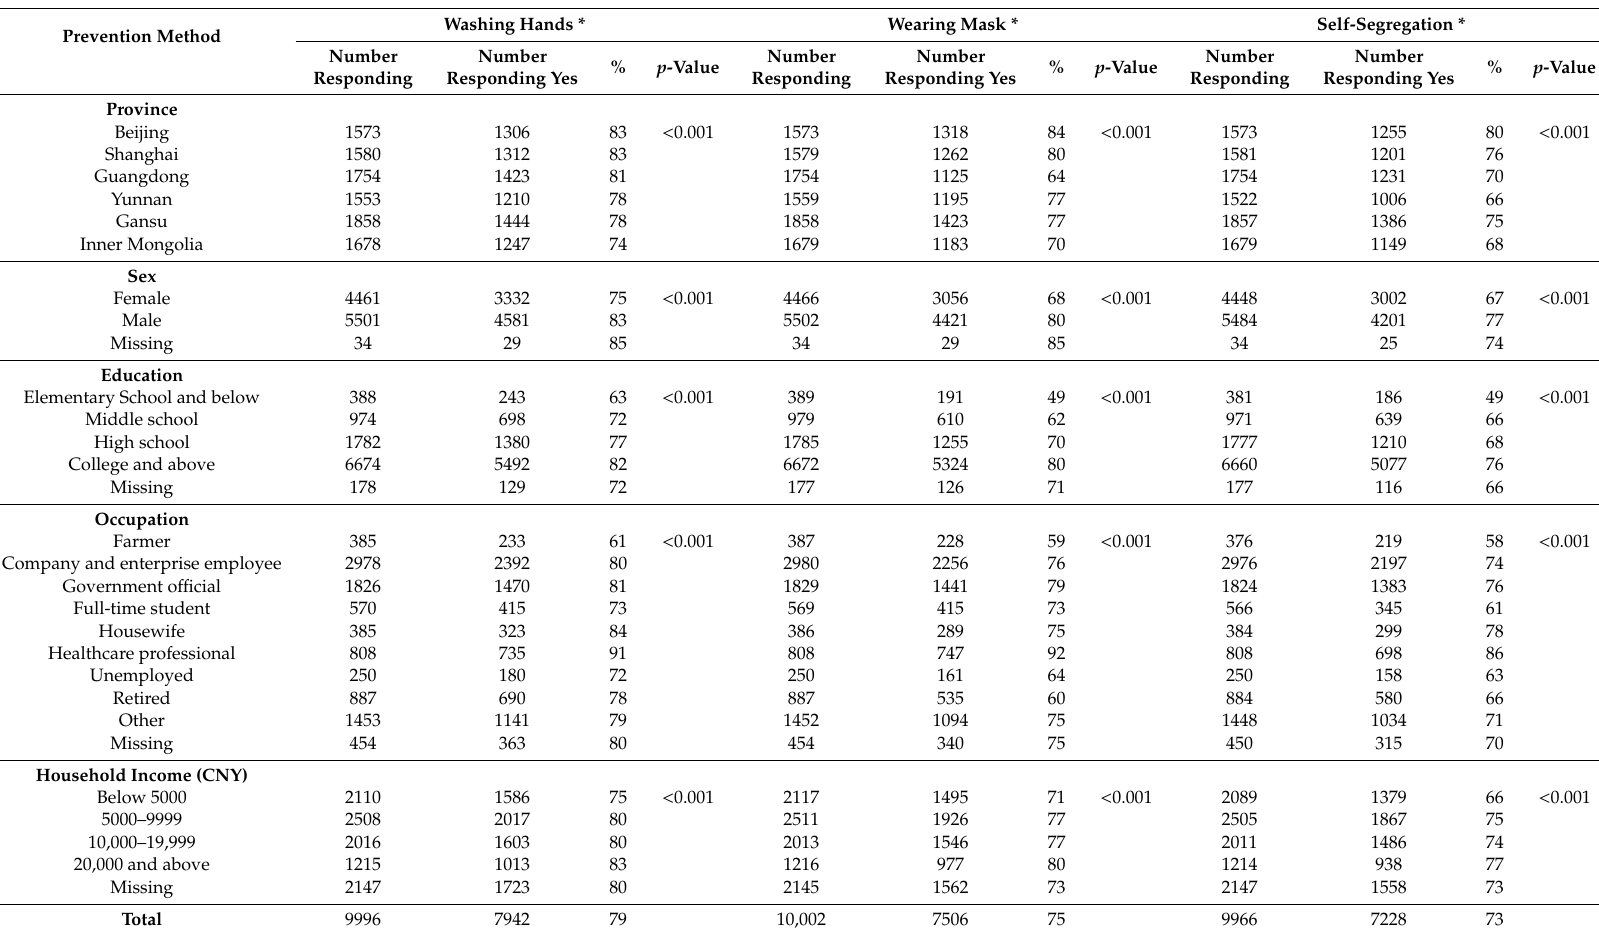
Table 2. Influenza prevention awareness of telephone survey respondents in six provinces of China, October 2017 to March 2018. Prevention